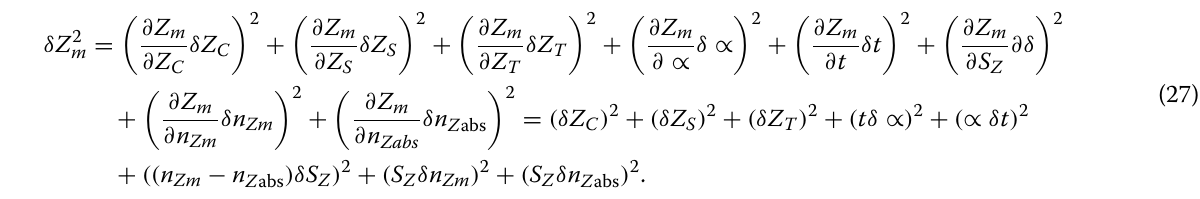
Term Uncertainty of the variable